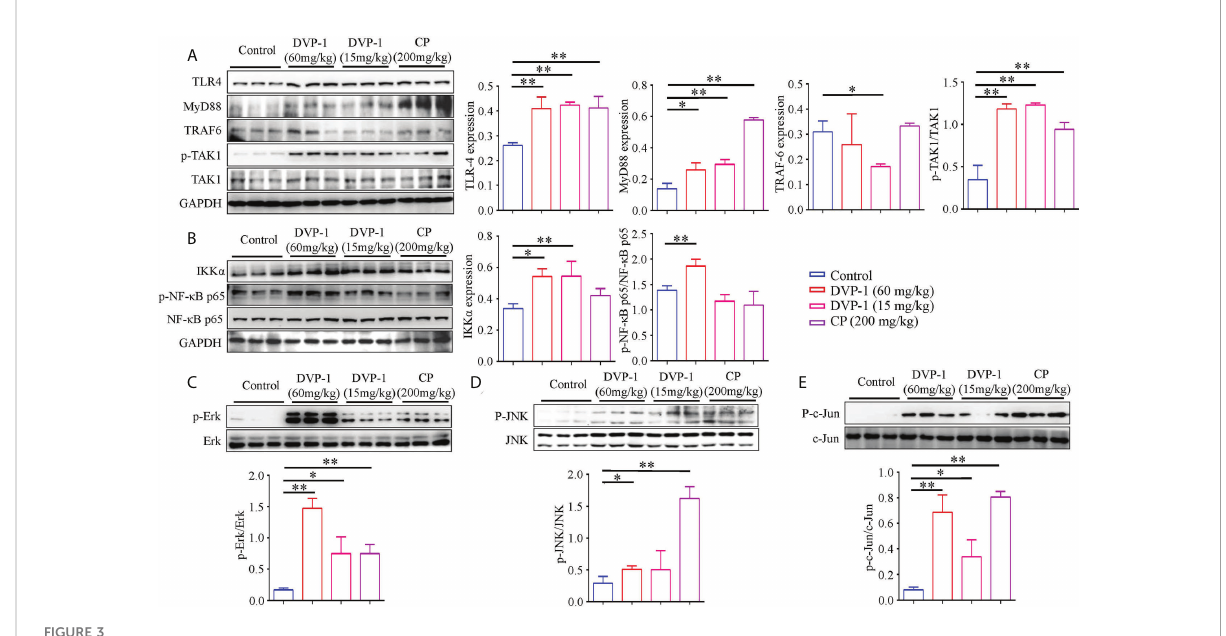
FIGURE 3 Western blot detection of key proteins in the TLR4/MyD88/NF- k B pathway. (A) Protein expression of TLR4, MyD88, TRAF6, TAK1, and phosphorylated TAK1 in spleen tissues as evaluated by Western blot. (B) Protein expressions levels of IKK a , and NF- k B and the phosphorylated NF- k B in spleen tissues were evaluated by Western blot. (C) Protein expression of total and phosphorylated Erk in spleen tissues as evaluated by Western blot. (D) Protein expression of total and phosphorylated JNK in spleen tissues as evaluated by Western blot. (E) Protein expression of total and phosphorylated c-Jun in spleen tissues were evaluated by Western blot. Each column represents the mean of three independent experiments. *p < 0.05, **p <